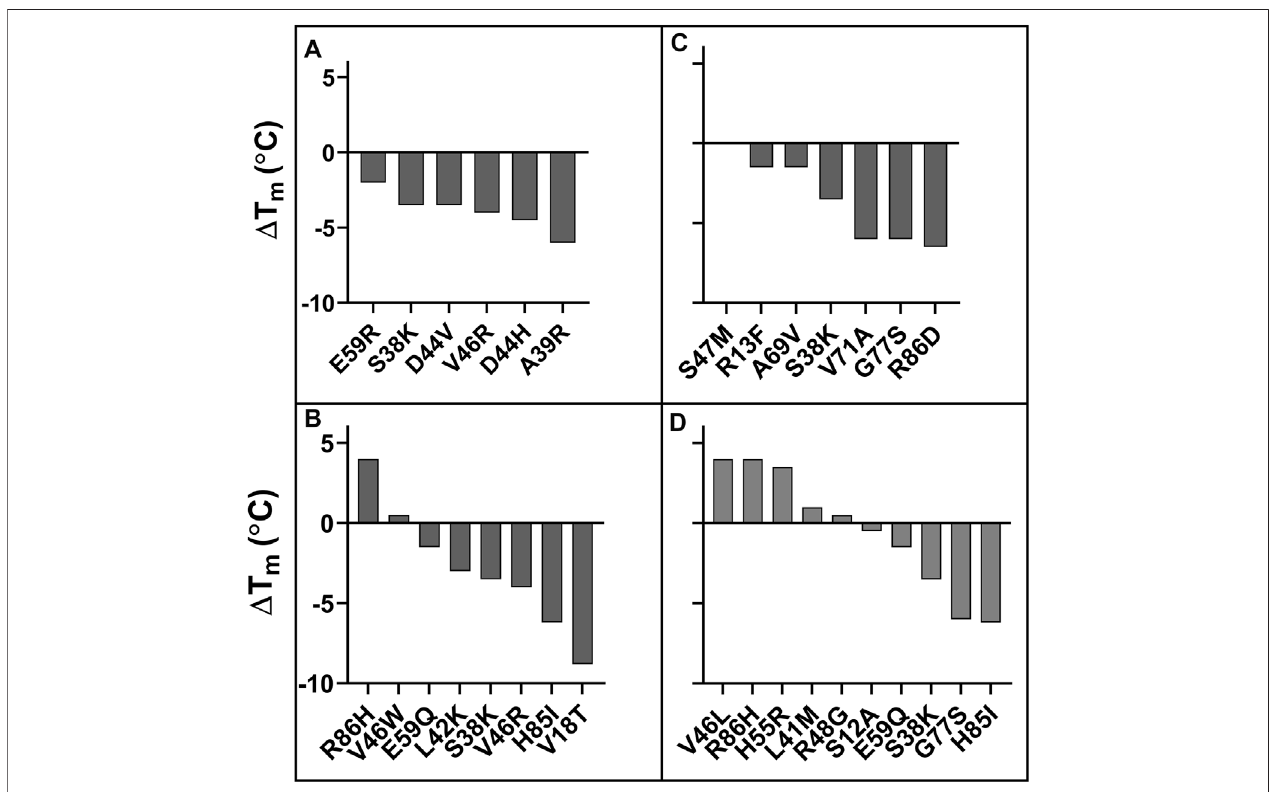
FIGURE 5 | Δ T m of putative stabilized CcdB mutants. Mutants were identi fi ed from (A) MFI seq (bind) at 5 nM GyrA14, (B) MFI seq (ratio) at 5 nM GyrA14, (C) MFI seq (bind) at 100 nM GyrA14, (D) MFI seq (ratio) at 100 nM GyrA14. The mutants were randomly selected from a subset of forty mutants which showed the highest MFI seq (bind) or the highest MFI seq (ratio) and had MFI seq (expr) >